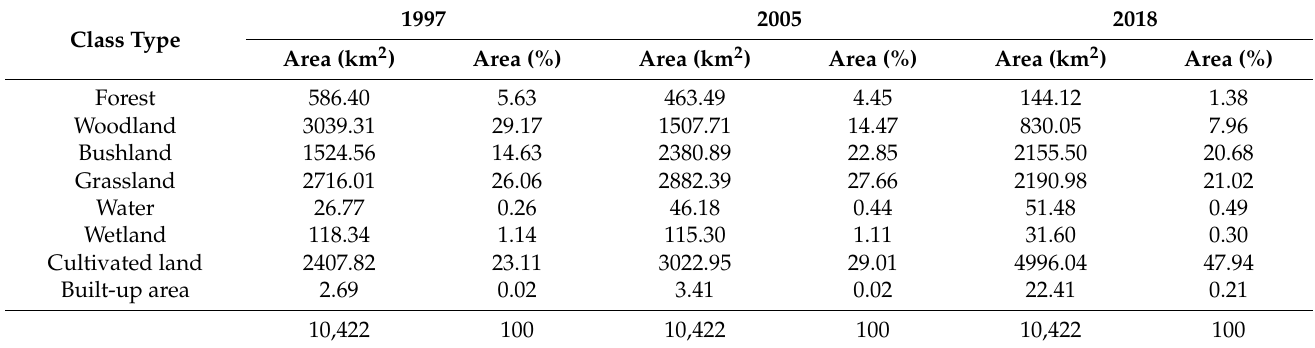
Table 5. Temporal land cover change matrix for the Singida